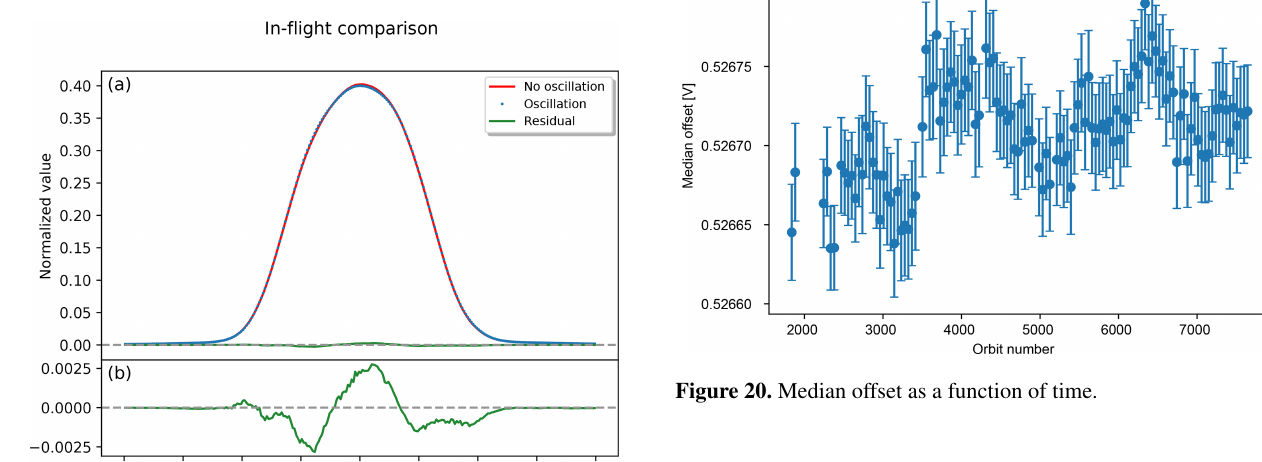
Figure 17. Comparison between the ISRF measurements taken with and without an oscillating diffuser. The measurements with an os- cillating diffuser are plotted in red and the measurements without an oscillating diffuser are plotted in blue.